Question: Sum up the contents of this chart in one sentence.
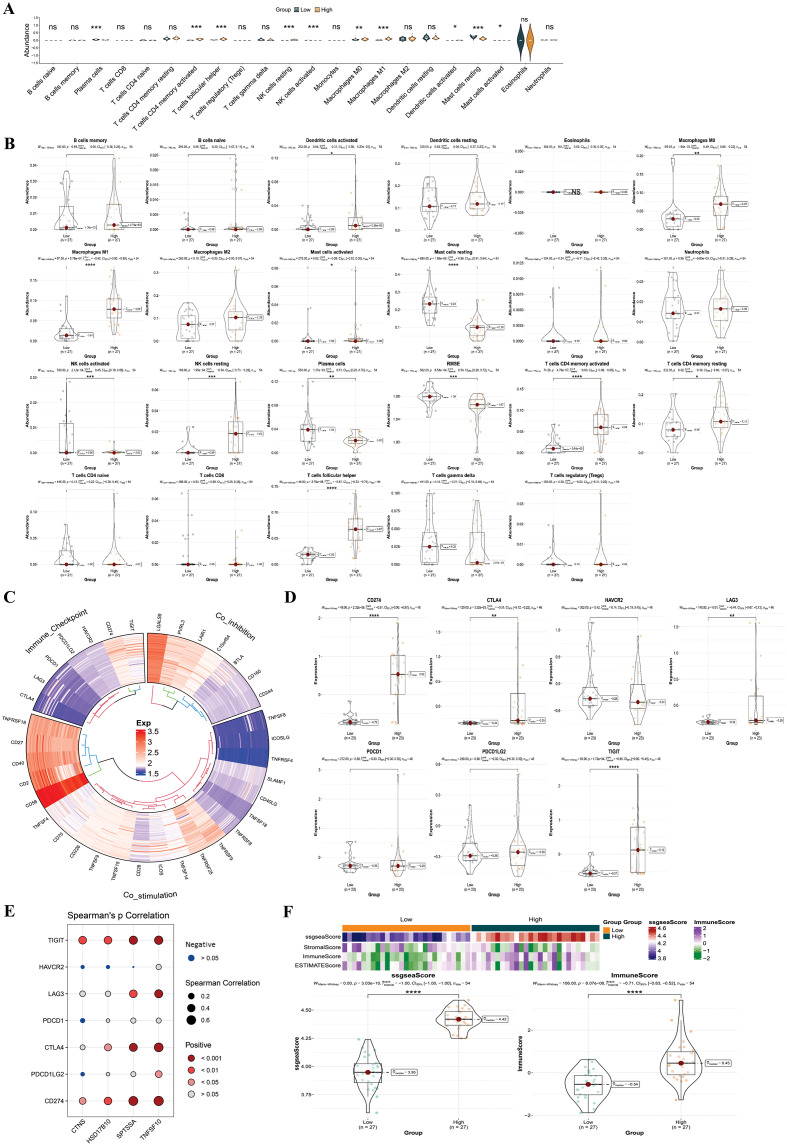
Answer: Immune microenvironment features associated with the palmitoylation-related score. (A) CIBERSORT-based differences in relative immune-cell abundance. (B) CIBERSORT-ABS-based differences in absolute immune-cell abundance. (C) Expression patterns of co-stimulatory and co-inhibitory immune-regulatory molecules. (D) Differential expression of key immune-checkpoint genes. (E) Correlation heatmap between stable biomarkers and immune-checkpoint molecules. (F) ESTIMATE-derived microenvironment scores. *P < 0.05, **P < 0.01, ***P < 0.001, ****P < 0.0001; ns, not significant.